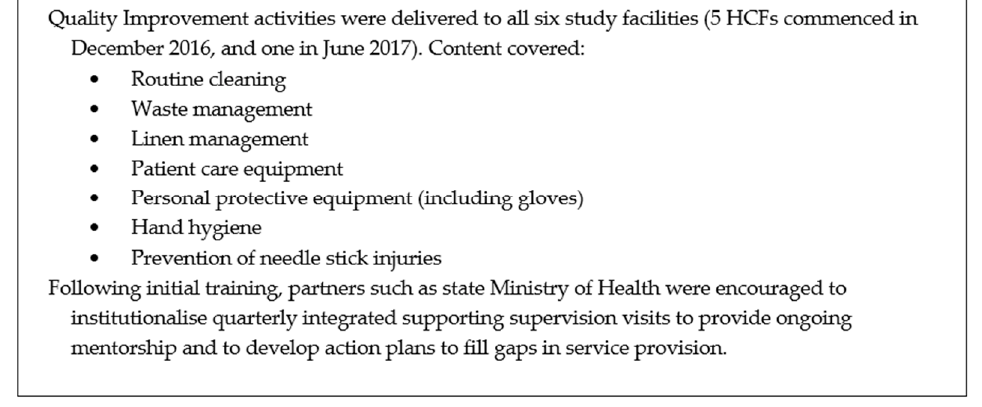
Figure 1. Details of Maternal and Child Survival Program (MCSP)-support quality improvement (QI) programming. HCF: healthcare facility.